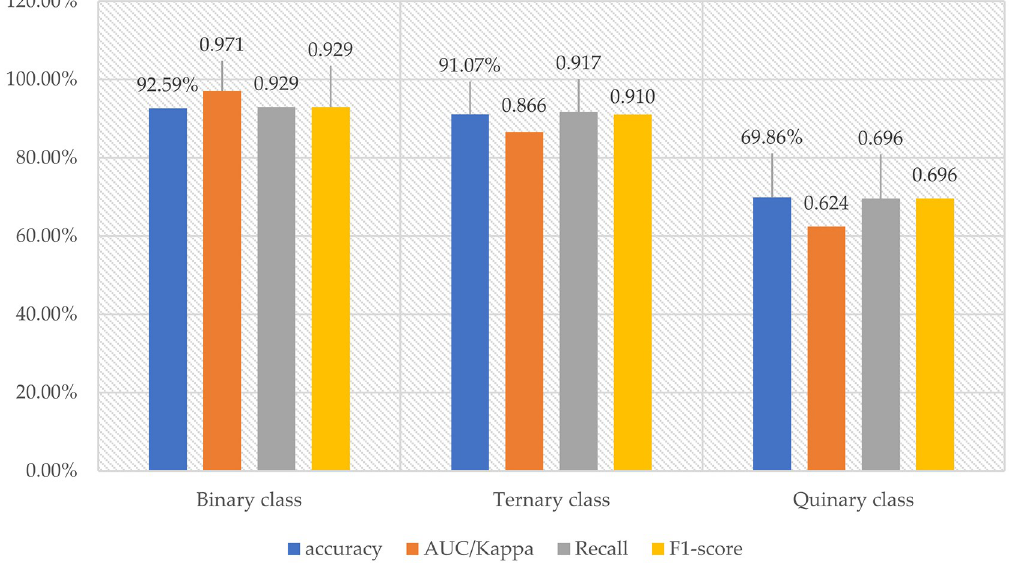
Fig 9. Comparison of accuracy and main performance indexes (binary: AUC; ternary and quinary: Kappa) of binary, ternary, and quinary classification models.